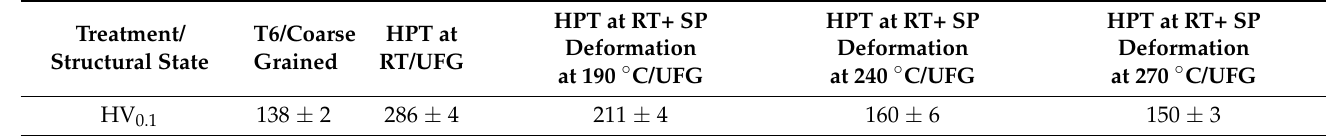
Table 2. Microhardness of 2024 Al alloy in different